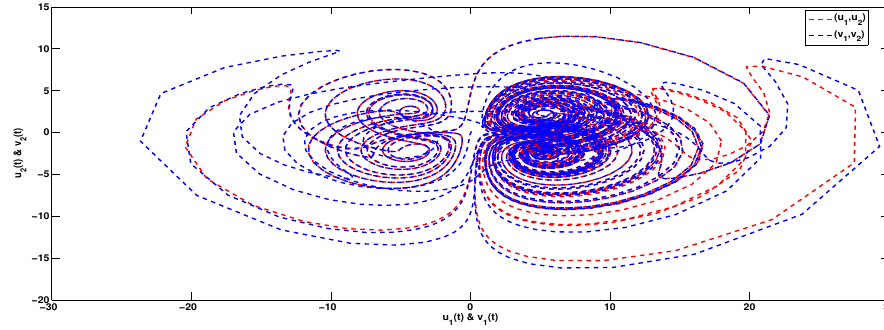
Figure 5. Chaotic behavior of the states ( u 1 ( t ) , u 2 ( t )) and ( v 1 ( t ) , v 2 ( t )) of the drive-response systems (13) and (14) with fractional order q = 0.9, respectively.